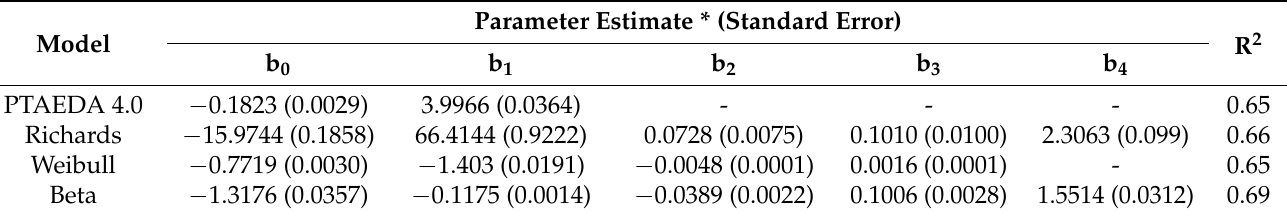
Table 3. Parameter estimates, standard errors, and the coefficient of determination (R 2 ) for live crown ratio models fitted within the study. Prediction equations are provided in Table 2.